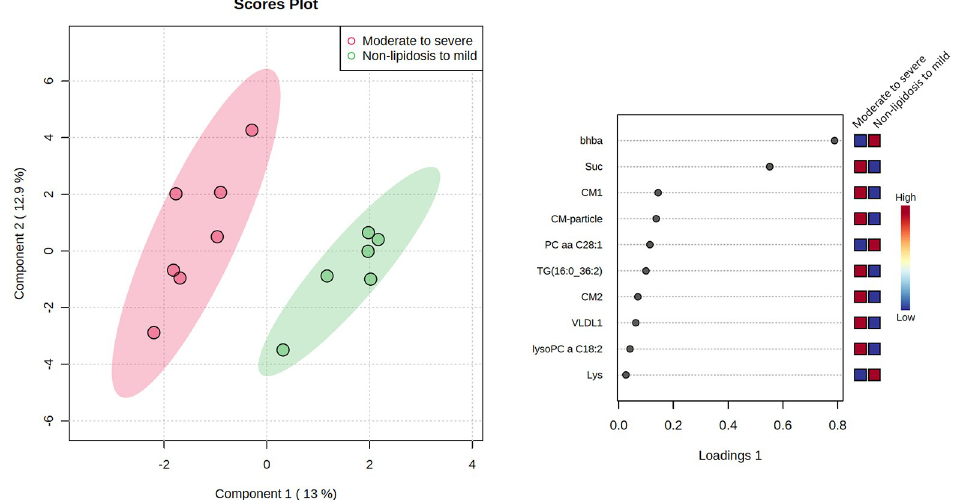
Fig 5. Box plot with superimposed dot plot of beta-hydroxybutyric acid (umol/L) across two simplified classes of hepatic lipid changes (no-lipid to mild and moderate to severe) in bearded dragons based on an established grading system [30] evaluated by a t-test. The dotted red line represents a cut-off value of 272 umol/L determined on receiver operating characteristic analysis.